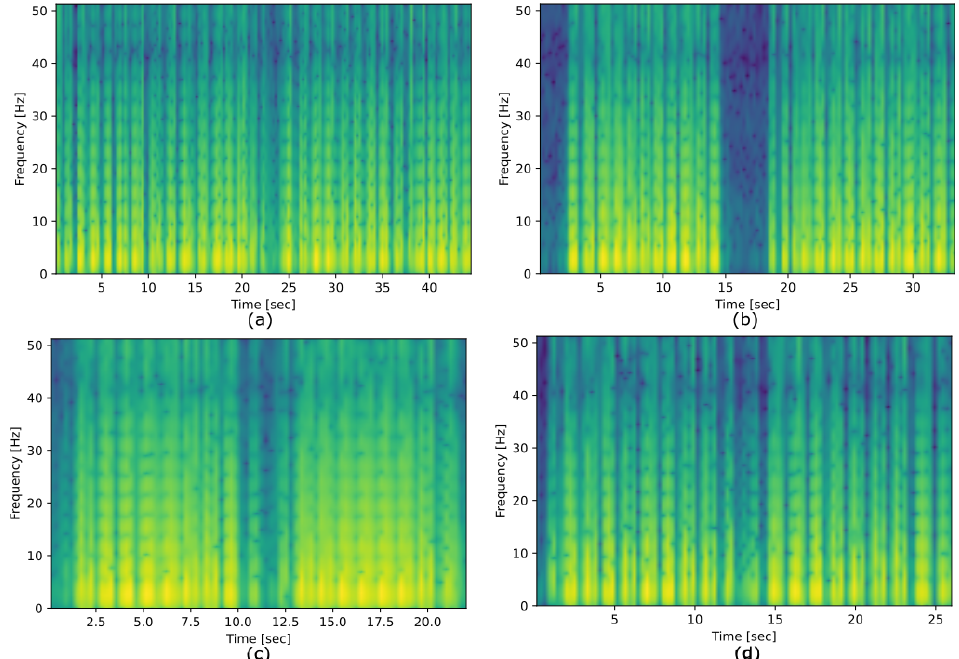
Figure 4. Resulting STFT computed to: ( a ) PD female patient, Lower limps score: 50, Age: 75; ( b ) PD female patient, Lower limps score: 10, Age: 65; ( c ) EHC female patient, Age: 50; ( d ) YHC female patient, Age: